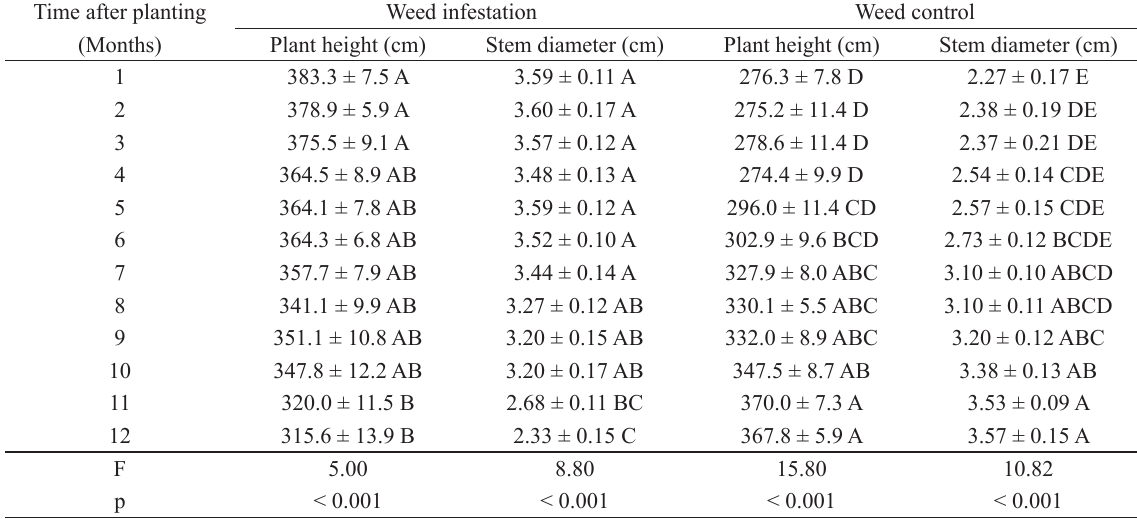
Plant height and stem diameter 24 months after planting of Hevea brasiliensis submitted to crescent periods of weed infestation or weed